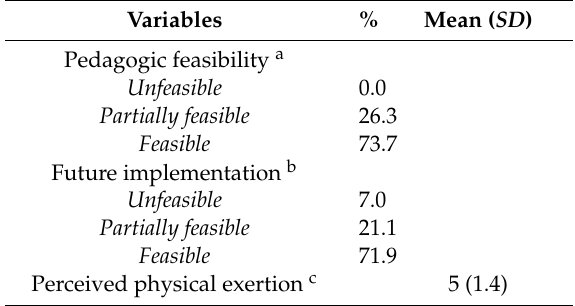
Table 2. Worker perceptions of Goldilocks-games feasibility and exertion ( n = 19). Variables % Mean ( SD ) Pedagogic feasibility a